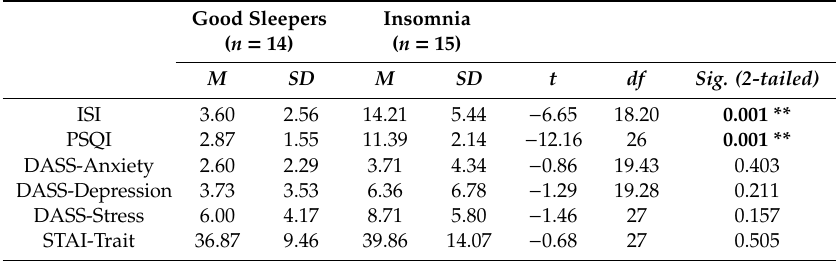
Table 1. Group comparisons and means and standard deviations for historic sleep quality and trait a ff ect.